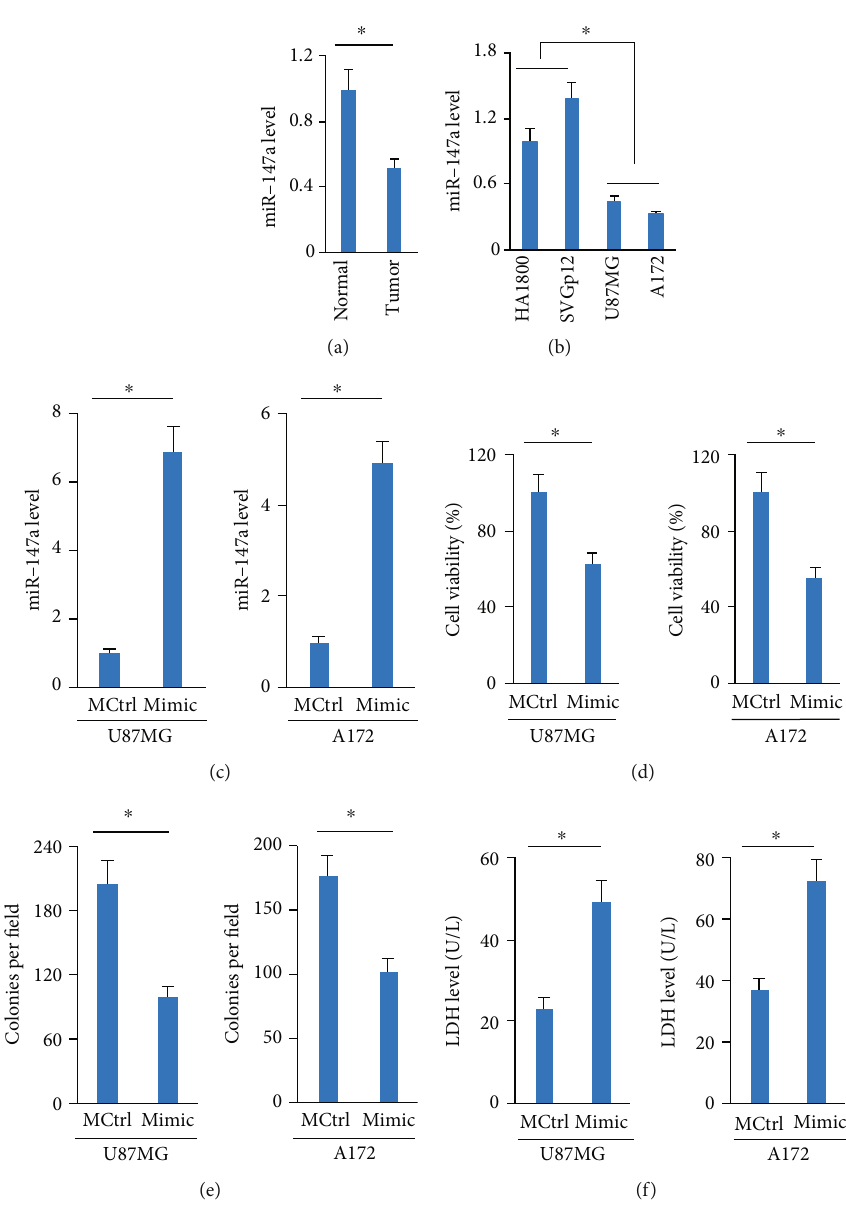
Figure 1: The miR-147a mimic suppresses cell survival and induces cell death of human glioblastoma cells. (a) miR-147a level in human glioblastoma tissues and normal brain tissues. (b) miR-147a level in human glioblastoma cells and normal brain astroglia cells. (c) miR- 147a level in human glioblastoma cells treated with or without the miR-147a mimic. (d) Cell viability detected by CCK-8 assay. (e) Numbers of colonies. (f) LDH level in the medium from cells treated with or without the miR-147a mimic. N = 6 for each group. Data were expressed as the mean ± SD , and P < 0 : 05 was considered statistically signi fi